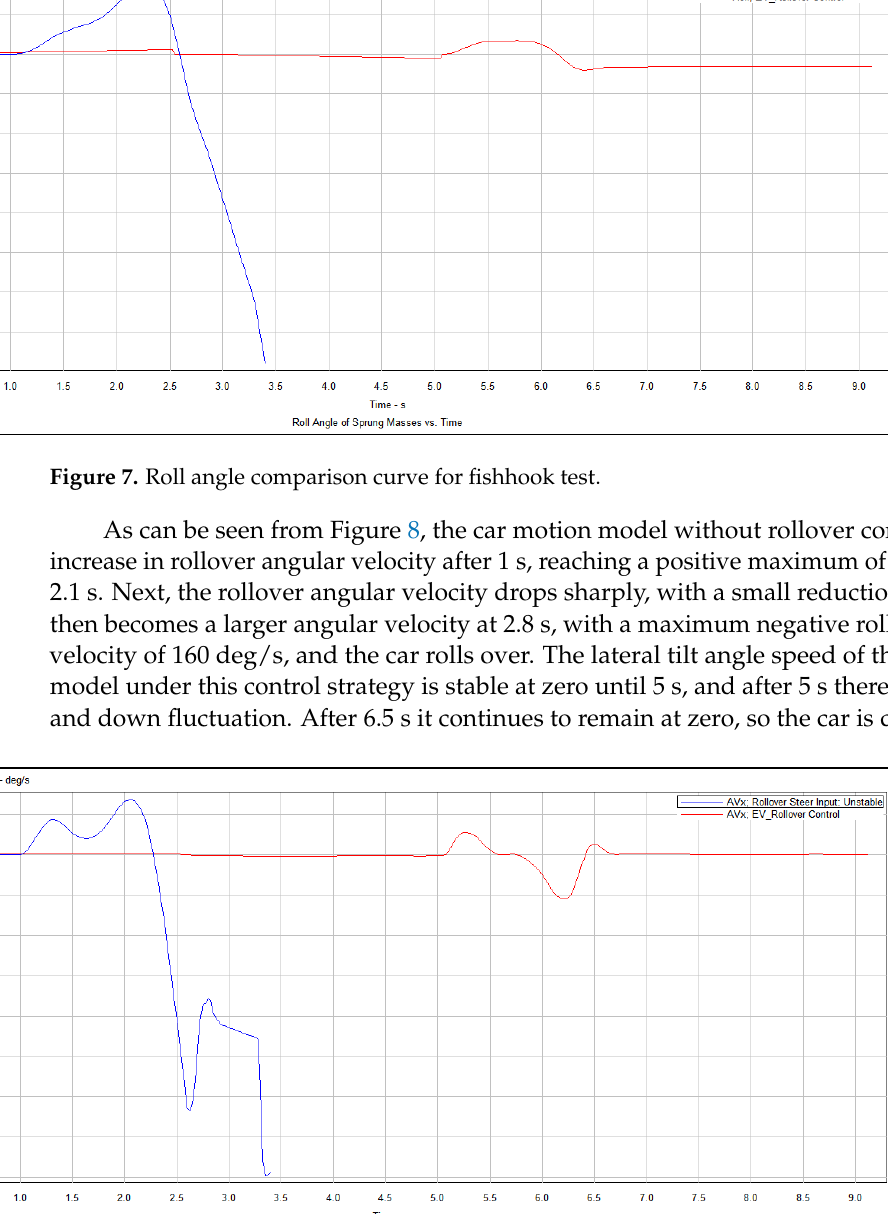
Figure 8. Roll angle comparison curve for fishhook test.